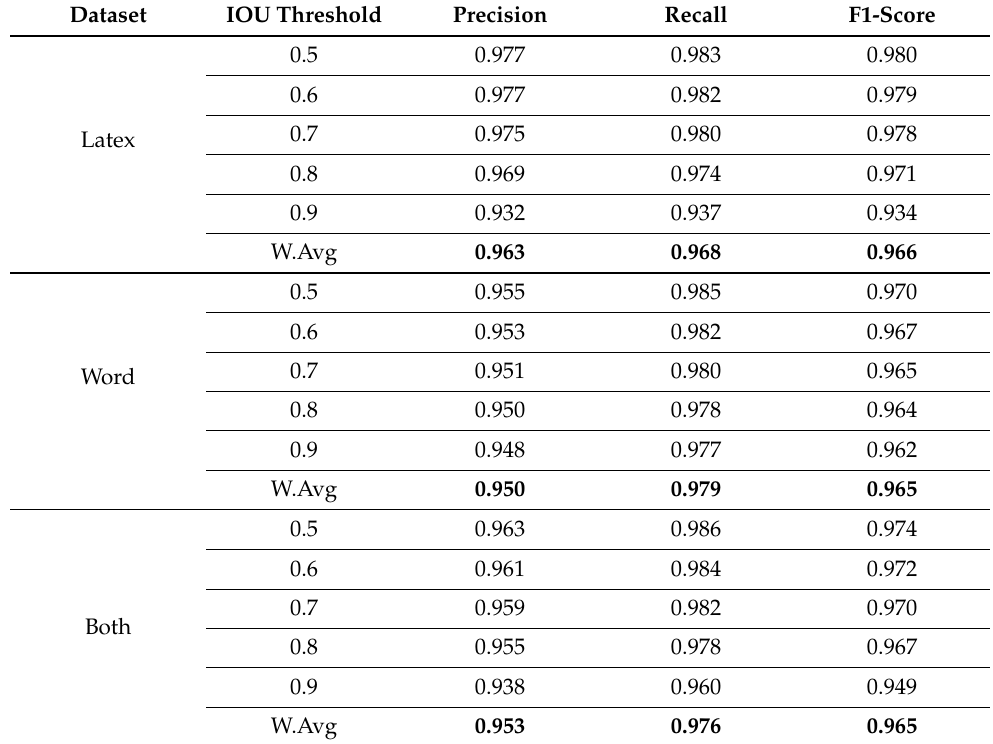
Table 3. HybridTabNet results on each document type of TableBank dataset. W.Avg denotes the weighted-average of the respective measure on the IoU threshold.